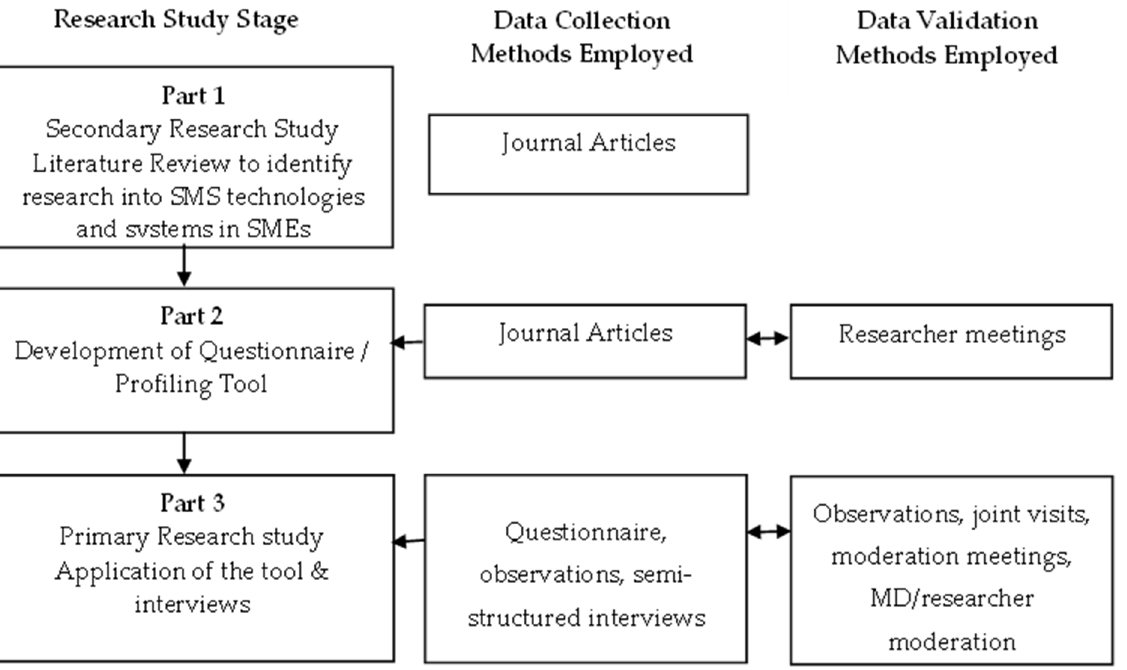
Figure 1. Research Method and Survey